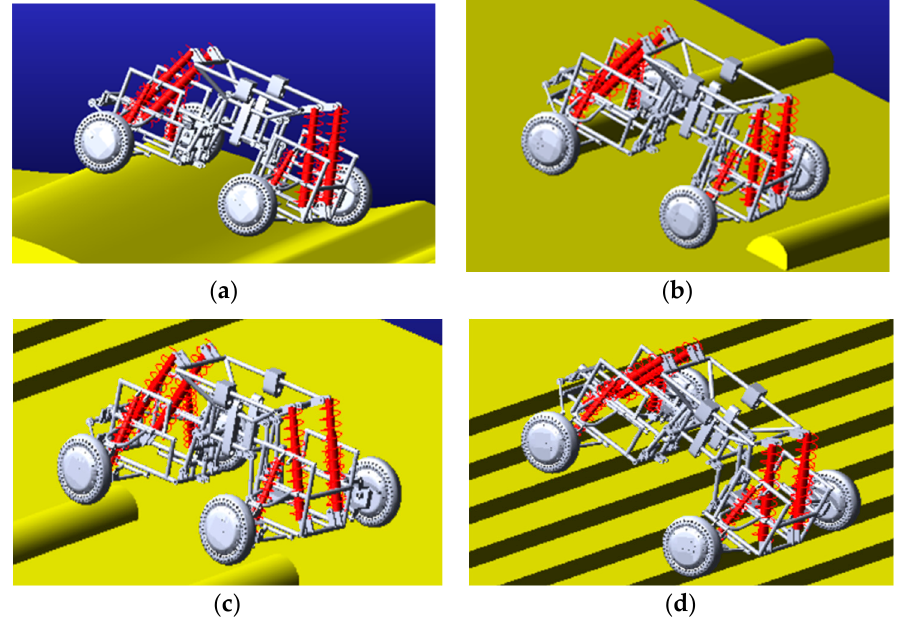
Figure 9. Animation simulation of obstacle crossing experiment. ( a ) Car driving through rough road, ( b ) The right suspension passes through the boss, ( c ) The left side suspension passes through the boss, ( d ) Car climbs up the